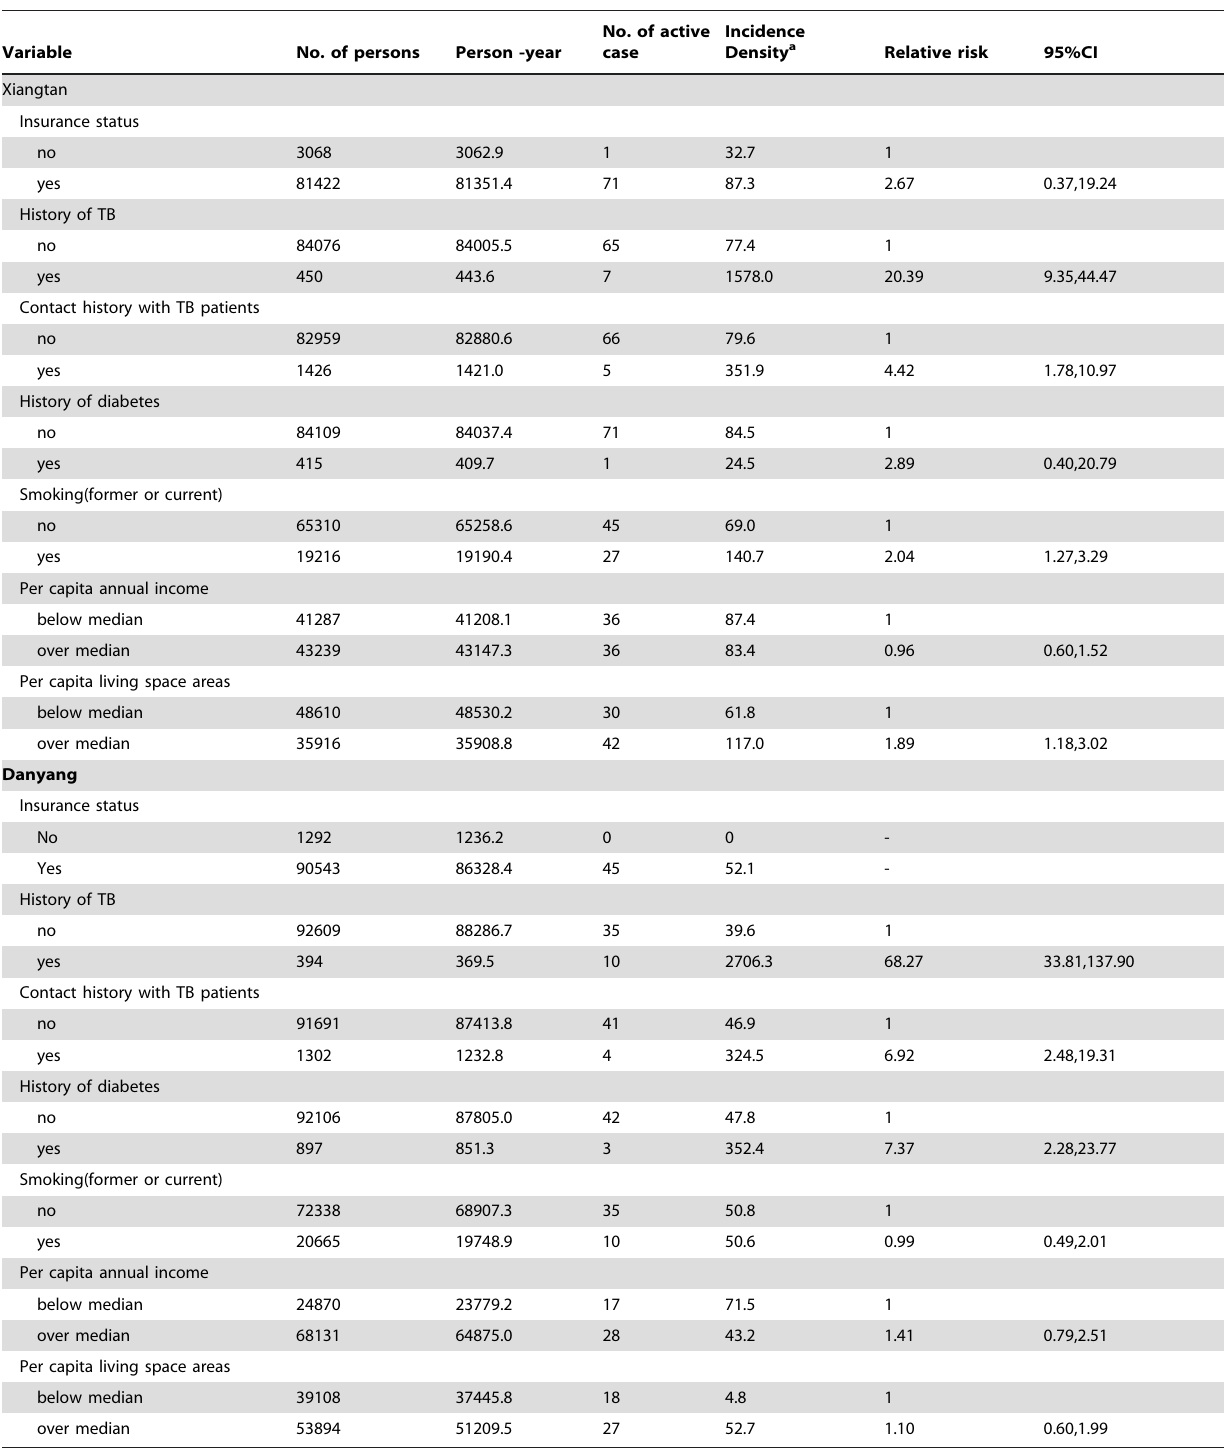
Table 3. Incidence and Relative Risk Under Exposed/Unexposed Conditions in the Study, 2009–2011.